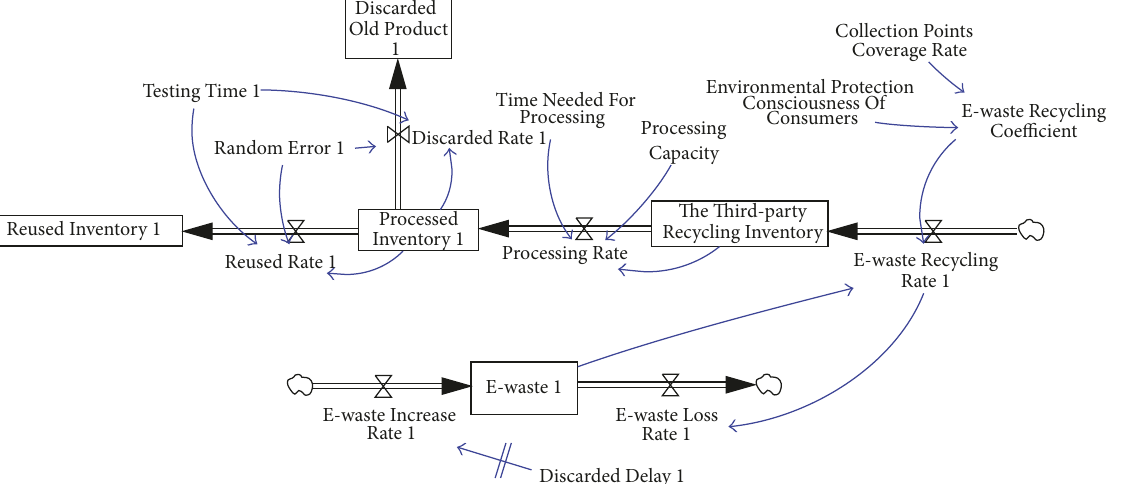
Figure 4: The third-party recycling mechanism flow diagram.